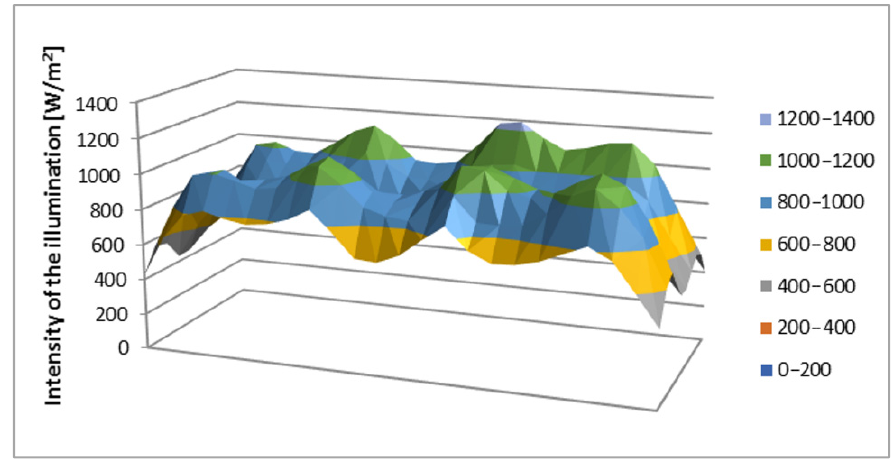
Figure 1. Reflector layout with the associated light intensity distribution. In the measurement setup, the average intensity is E average = 861 W/m 2 . These data correspond to a value measured on a slightly cloudy day, lower than in clear, sunny weather, which is 1000 W/m 2 in Hungary. According to Wien’s law [22], a constant determination is required because there is a significant spectral energy shift between halogen reflector light and natural sunlight. Based on Figure 2, the constant of the light spectral composition is 0.532, which is the quotient of the areas under the curve and determined by a spectrophotometer [1,20,23,24]. It means that with a halogen reflector solar simulator compared to natural sunlight, the measured current is 53.2% of the real one (Figure 2).